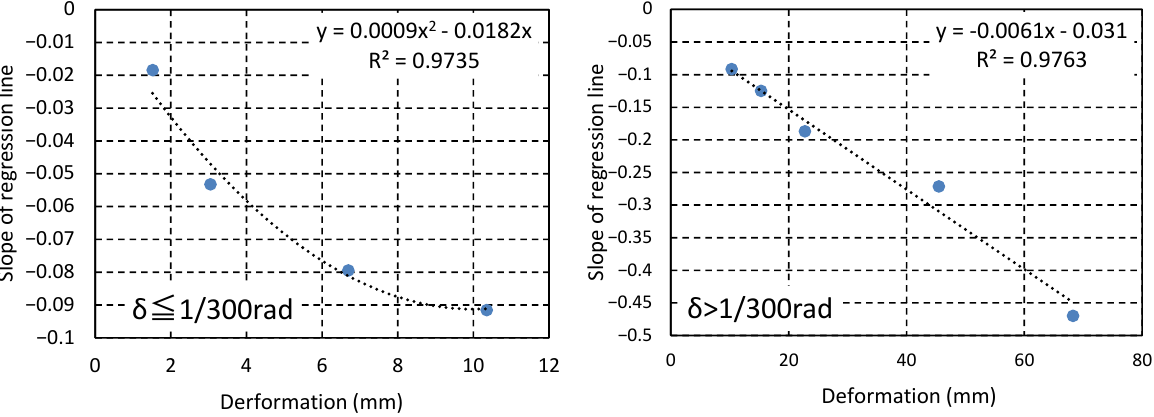
Figure 7. Relationship between deformation and slope of regression line. (Gypsum